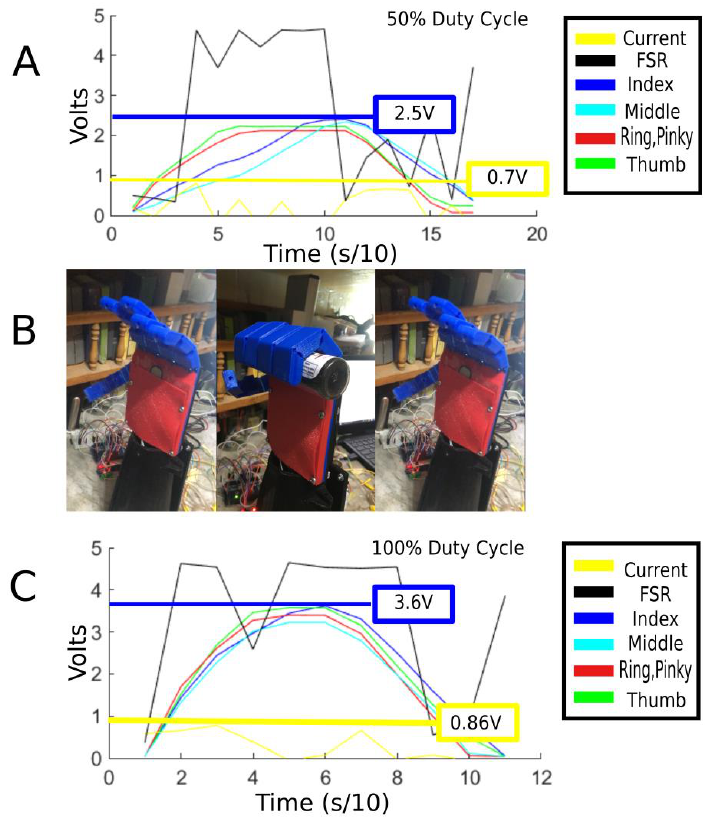
Figure 5. Details of the current sensing experimentation. ( A ) Graph showing the current sensor peak at 0.7 V using 50% duty cycle for the finger actuators. ( B ) Image showing the transition of the hand from an open position to grasping to an open position again in alignment with the graphs. ( C ) Graph showing the current sensor peak at 0.86 V using 100% duty cycle for the finger actuators.